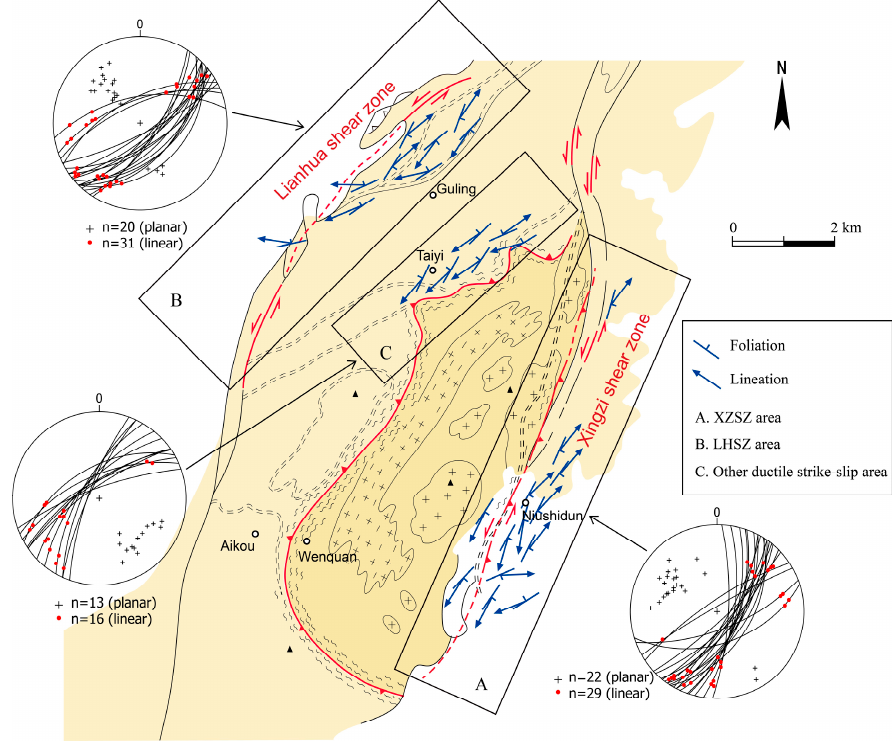
Figure 3. The planar and linear structural elements in ( A ) mylonites, measured within the XZSZ area; ( B ) mylonitic rocks, measured within the LHSZ area; and ( C ) ductile-deformed rocks, measured within the strike-slip ductile shear zones, north of the Lushan Massif. All the diagrams are equiareal, lower hemisphere Schmidt nets. Stereographic projections show a consistent trend of NE-NNE of ductile strike-slip structures in the Lushan Massif.